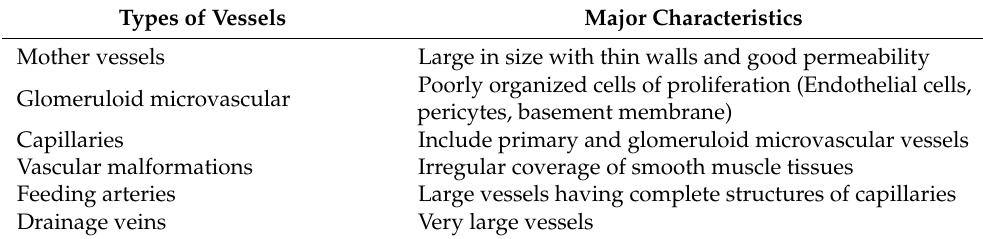
Table 1. Types of vessels in solid tumors